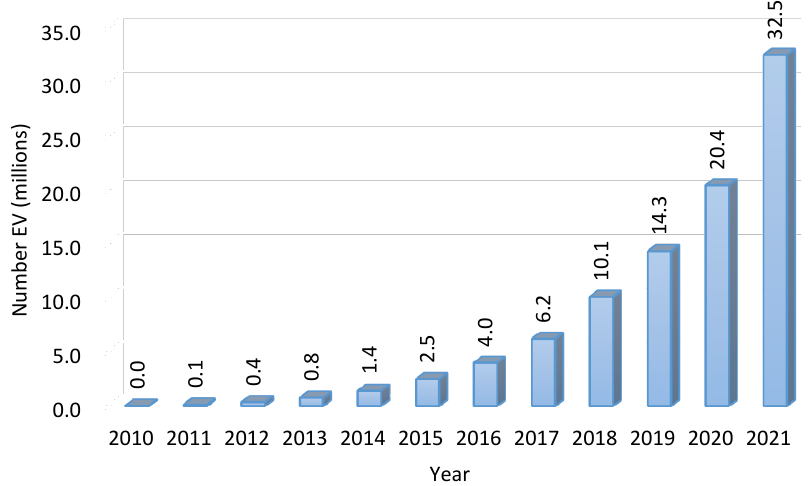
Figure 1. Growth of the global EV population in 2010–2021. Adapted from Ref. [1].